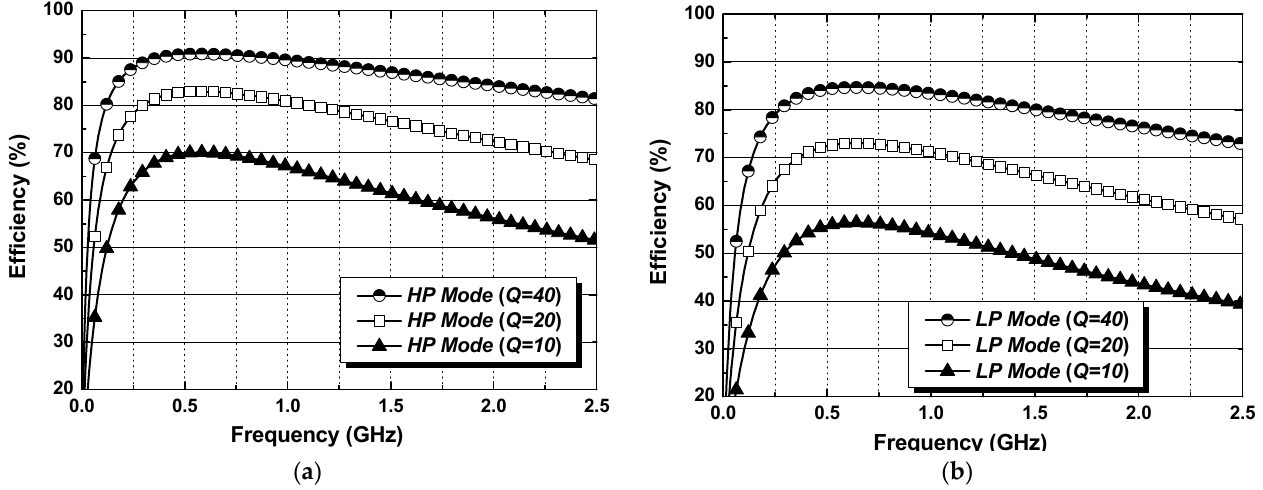
Figure 3. Transformer efficiencies of the PCT calculated for different Q values ( a ) HP mode ( b ) LP mode. Figure 4 shows a 3D view of the proposed PCT using a four-layer FR4 PCB. The size of the PCT is 2.2 mm × 2.2 mm.